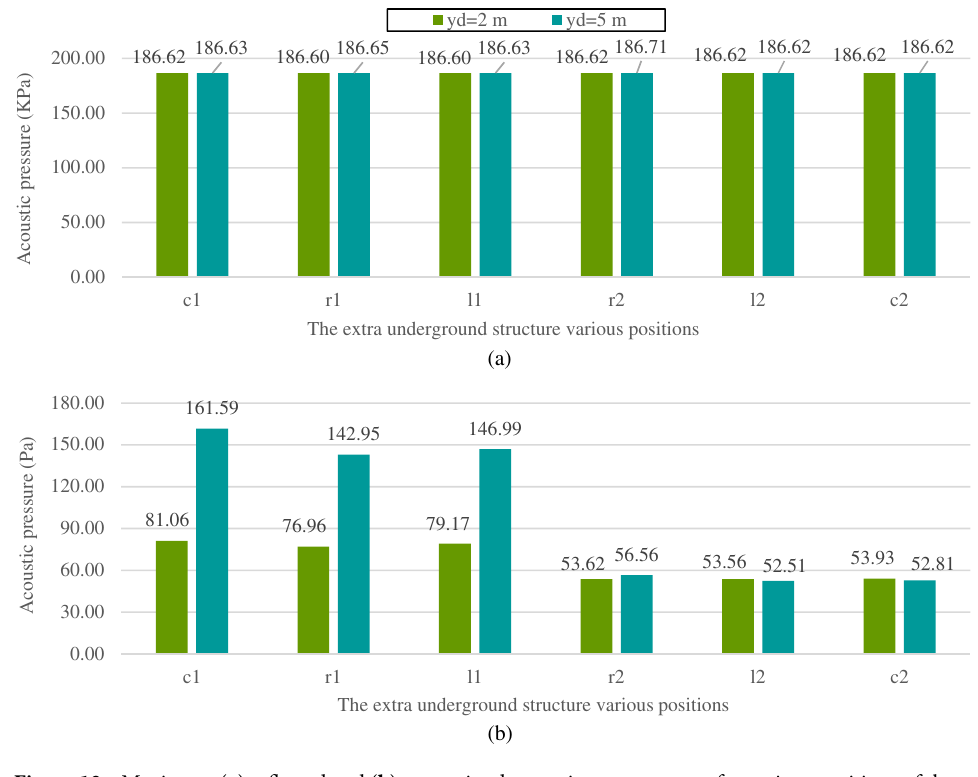
Figure 12. Maximum ( a ) reflected and ( b ) transmitted acoustic wave pressure for various positions of the extra underground